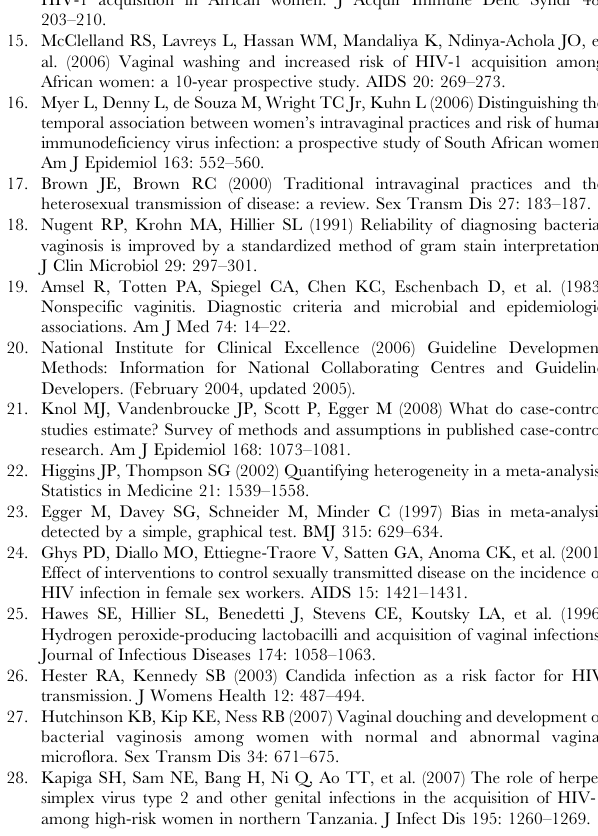
Table S3 Studies reporting associations between intravaginal practices and vaginal infections (objective 2). BV, bacterial vaginosis; HSV2, herpes simplex virus type 2; H2O2, hydrogen peroxide producing Lactobacillus spp. ; NR, not reported; TV, Trichomonas vaginalis ; WBC, white blood